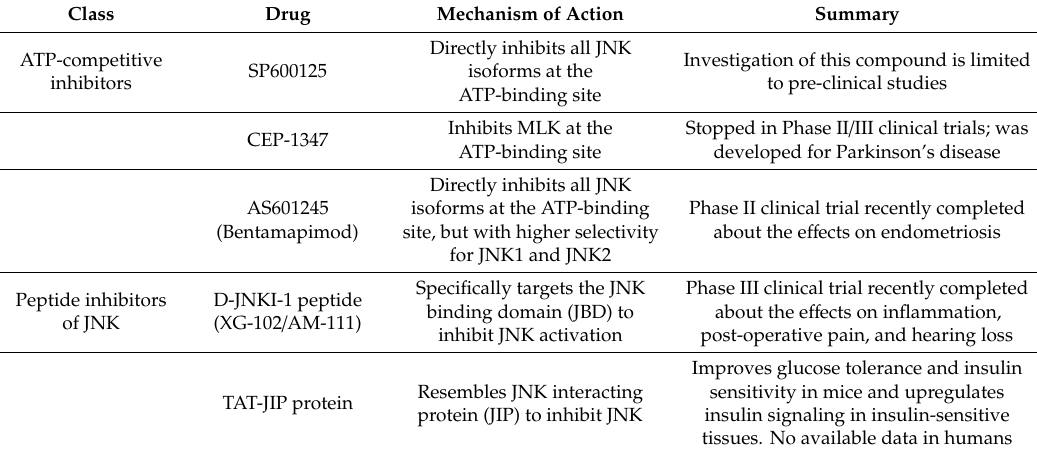
Table 1. Summary table of JNK inhibitors that have been studied. There are two main classes of inhibitors: the ATP-competitive inhibitors, and the peptide inhibitors of